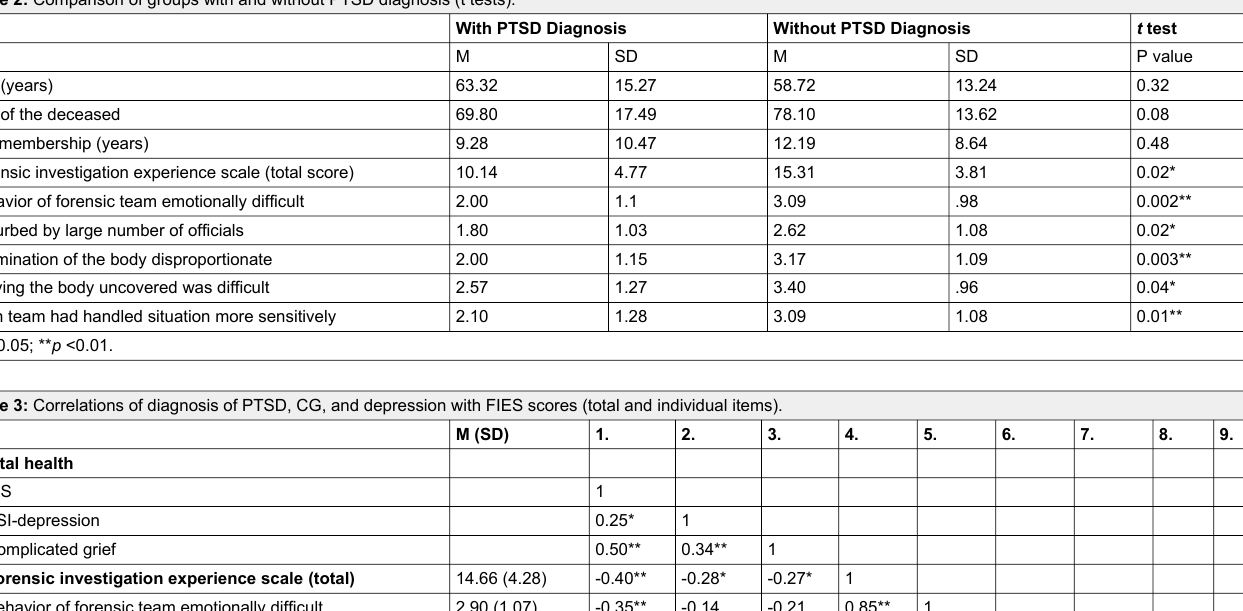
Table 2: Comparison of groups with and without PTSD diagnosis (t tests).